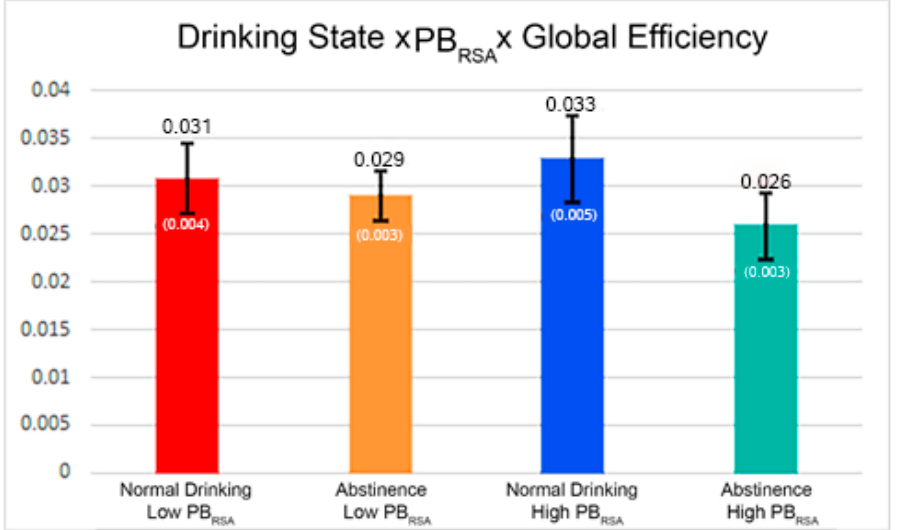
Figure 2. (Trending only). The bars capture the slope of the relationship between global efficiency and connection strength, across drinking states and as PB RSA increases. Numbers above the bar are slope values, and numbers in parenthesis are standard error. At both the upper and lower bounds of PB RSA , the relationship between global efficiency and strength was steeper during normal drinking. At lower PB RSA values, the slope decreased minimally during abstinence, whereas at higher PB RSA values, the slope decreased to a more significant degree following abstinence. Table 2. Relevant mixed-model strength results. Full model results are available in the Supplemen- tary Material.